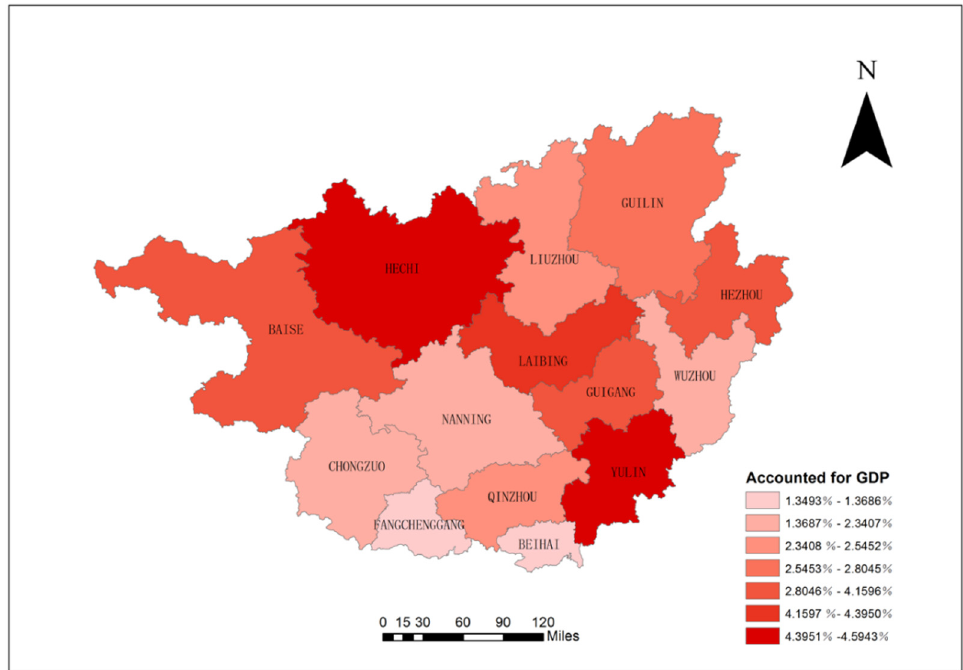
Figure 5. Economic loss (% of GDP) from air-pollution-caused health damage.